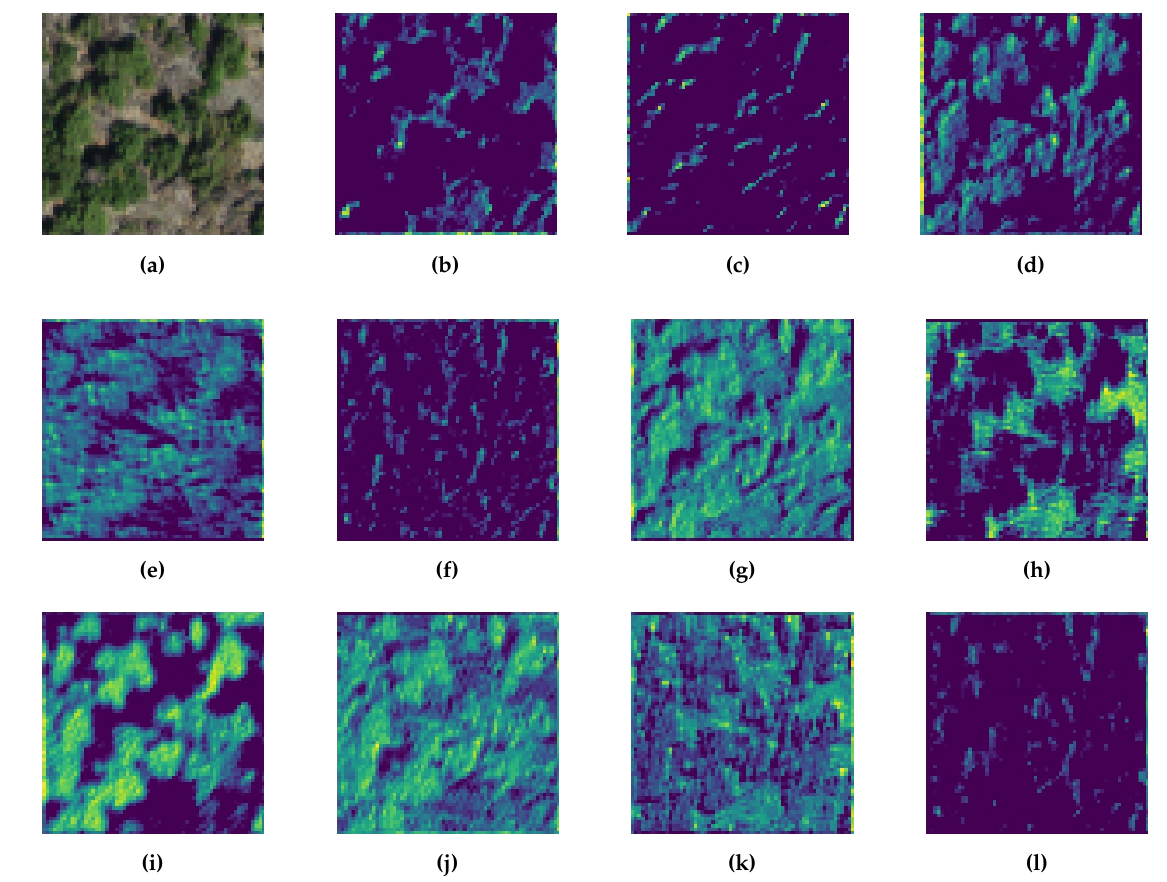
Figure 13. First convolutional layer features: ( a ) input image; ( b , h ) light areas; ( c , f , l ) low reflected areas (shadows); ( d , e , i ) green areas; ( g , j , k ) textures (roughness or